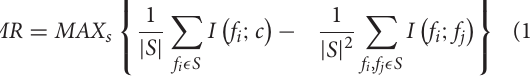
algorithm. The MRMR feature selection algorithm